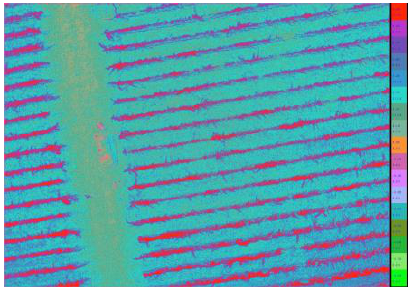
Figure 21. Ortophoto with NDVI values September 2 nd